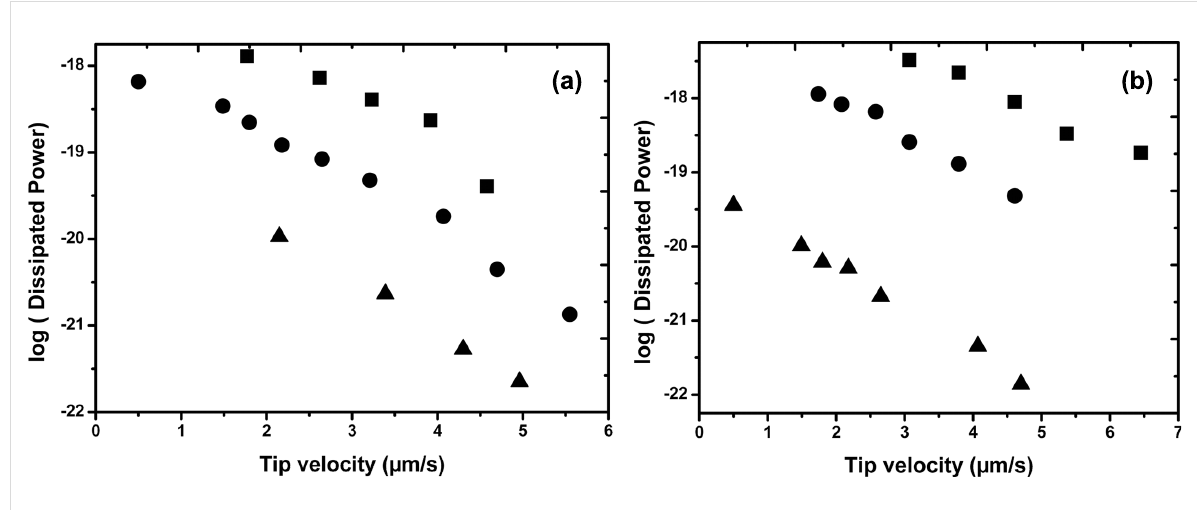
Figure 10: Logarithm of the dissipated power in moving as-synthesized NPs on silicon wafer versus the tip scan speed. Substrates: circles : SiO 2 silicon wafer; squares : NH 2 -coated silicon wafer (hydrophilic substrate); triangles : CH 3 -coated silicon wafer (hydrophobic substrate). (a) 35 nm diam- eter Au NPs, (b) 60 nm diameter Au